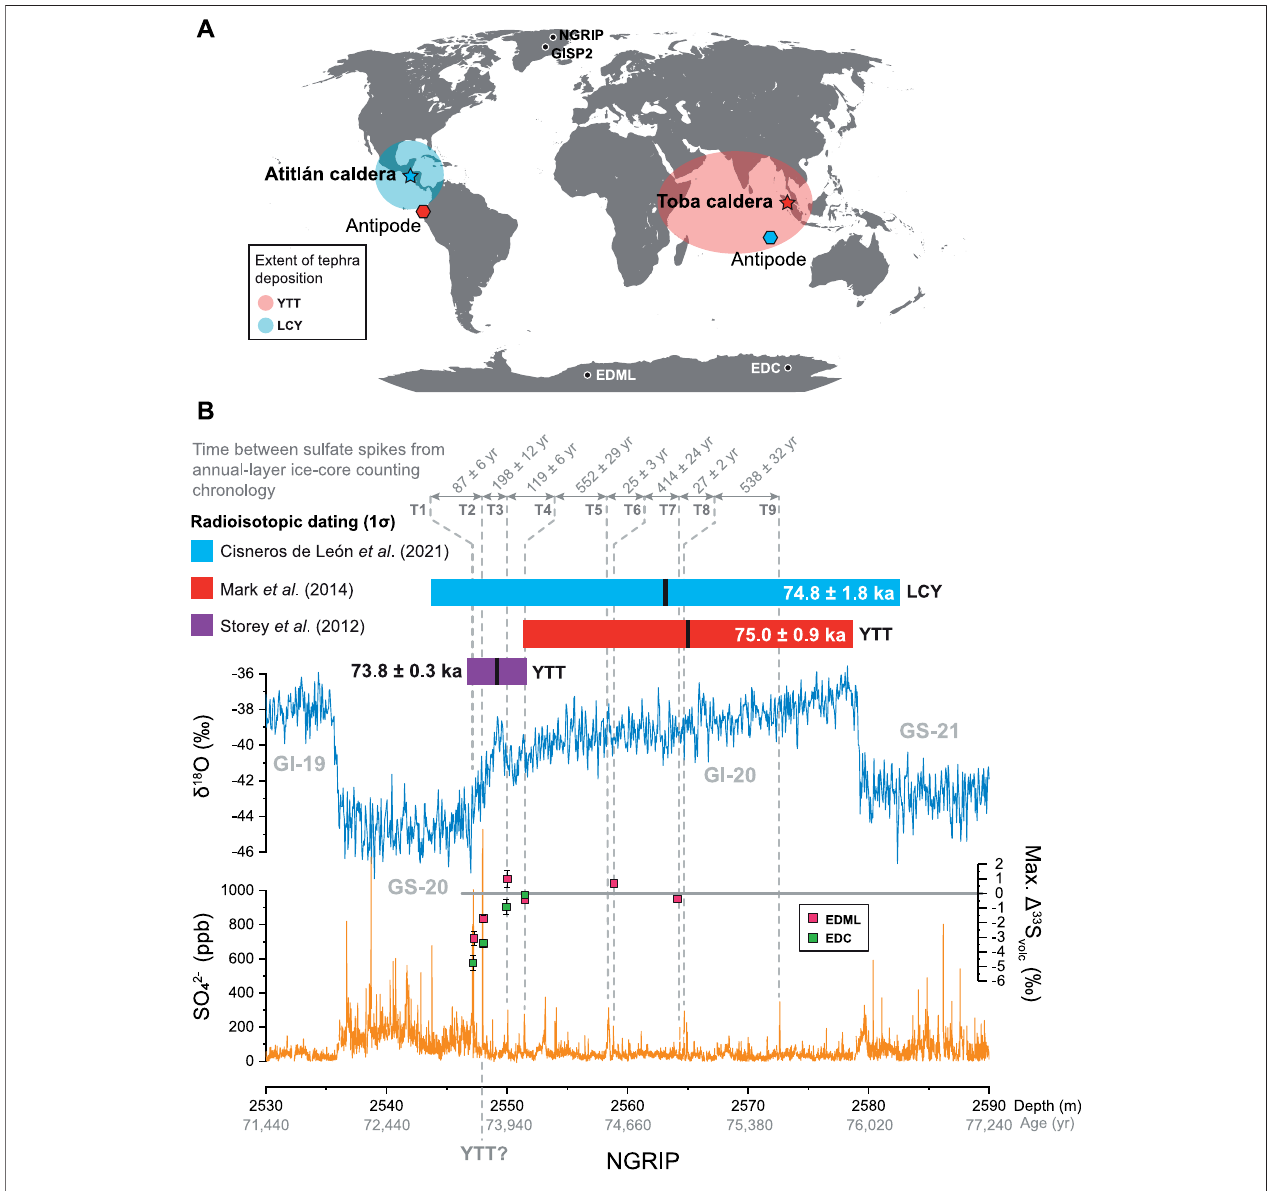
FIGURE 1 | Spatial and geochronological information for the YTT and LCY projected over climate and volcanic proxy signals from the northern and southern hemisphere ice core records. (A) Location map of the Toba (Sumatra) and Atitlán calderas (Guatemala), their respective antipodes (hexagons) and approximate tephra distribution. (B) Synchronization of the YTT and LCY radioisotopic ages (±1 σ ) with the NGRIP oxygen isotope and sulfate concentration records around the Greenland Interstadial 20 (GI-20) and the Greenland Stadial (GS-20) as well as the sulfur isotopic compositions from the EPICA Dronning Maud Land (EDML, Antarctica), and the EPICA dome C (EDC, Antarctica) ice core records (Crick et al., 2021). Dashed gray lines indicate the candidate sulfate anomalies for the YTT supereruption in the NGRIP and Antarctic ice cores ( Supplementary Figure S1 ). We only consider that bipolar S spikes are candidates for an equatorial supereruption.